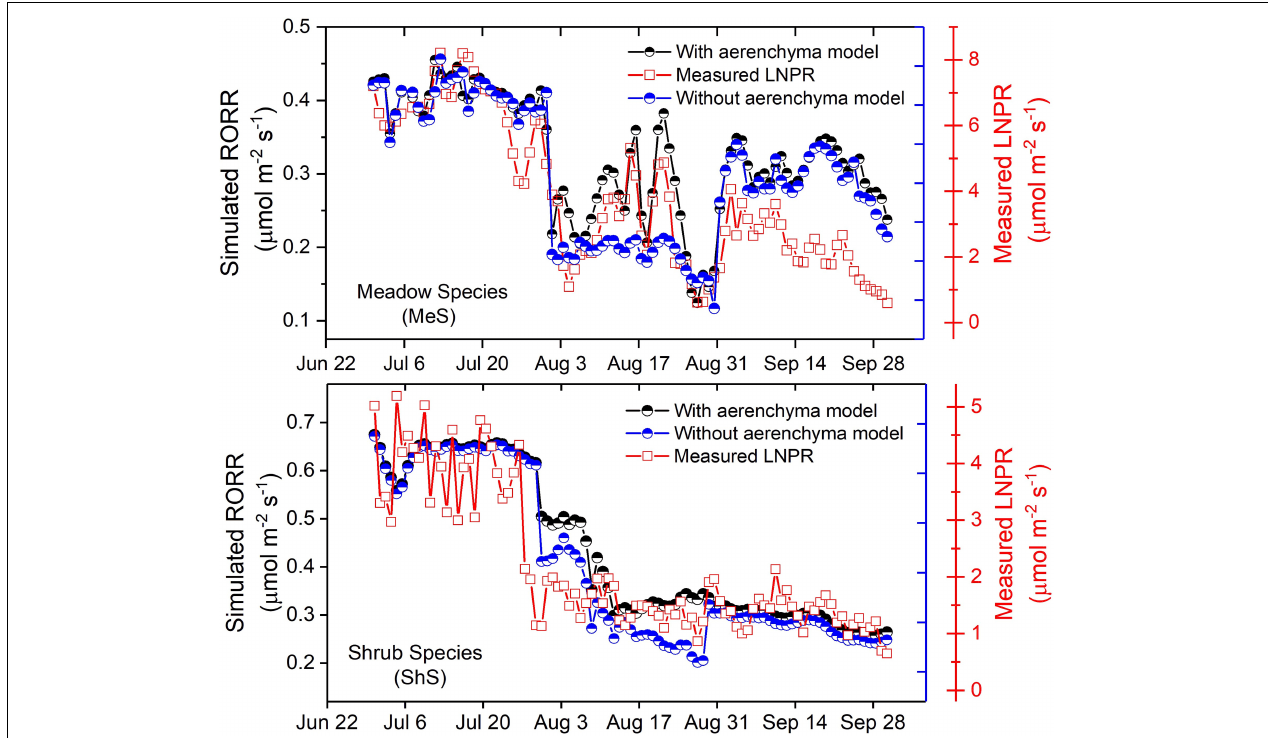
FIGURE 5 | Comparison of the RORR and LNPR simulation results of the MeS and ShS with and without the aerenchyma sub-model.